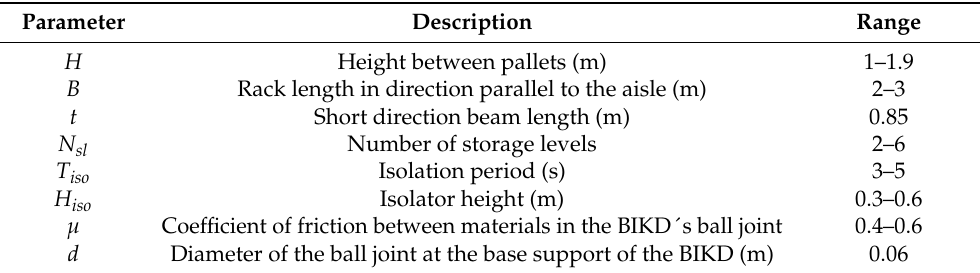
Table 2. Range of design parameters used in the analysis with LSH